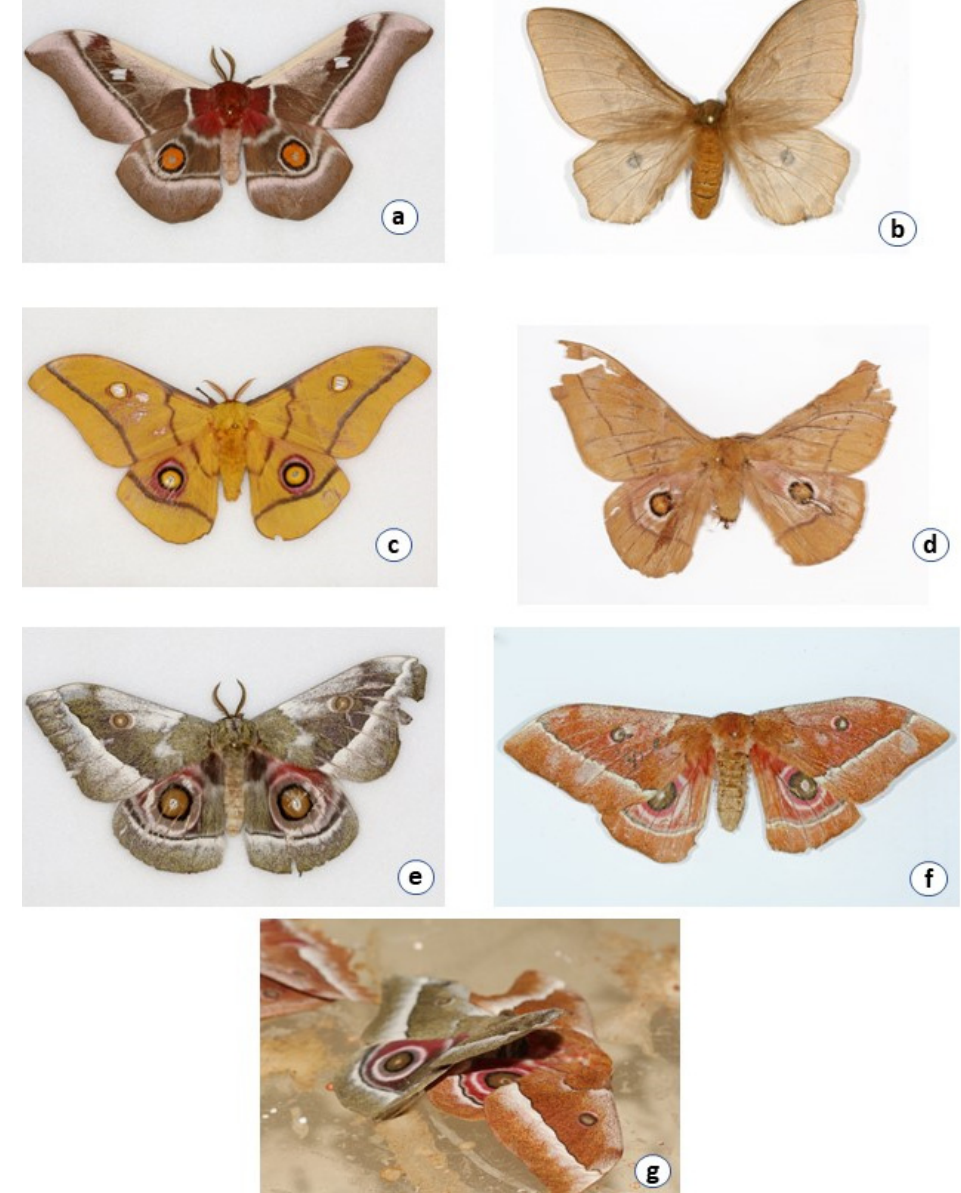
Figure 3. Pictures of saturniid moths. ( a ) Bunaea alcinoe , ( b ) Cirina forda , ( c ) Gonimbrasia krucki , ( d ) Gonimbrasia belina , ( e ) green form of Gonimbrasia zambesina , ( f ) brown form of Gonimbrasia zambe- sina , ( g ) mating pair of brown and green form of G. zambesina . ( g ) mating pair of brown and green form of G. zambesina